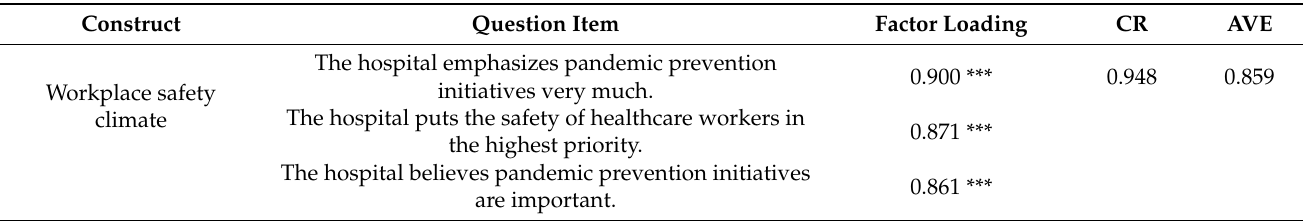
Table 2. Results of confirmatory factor